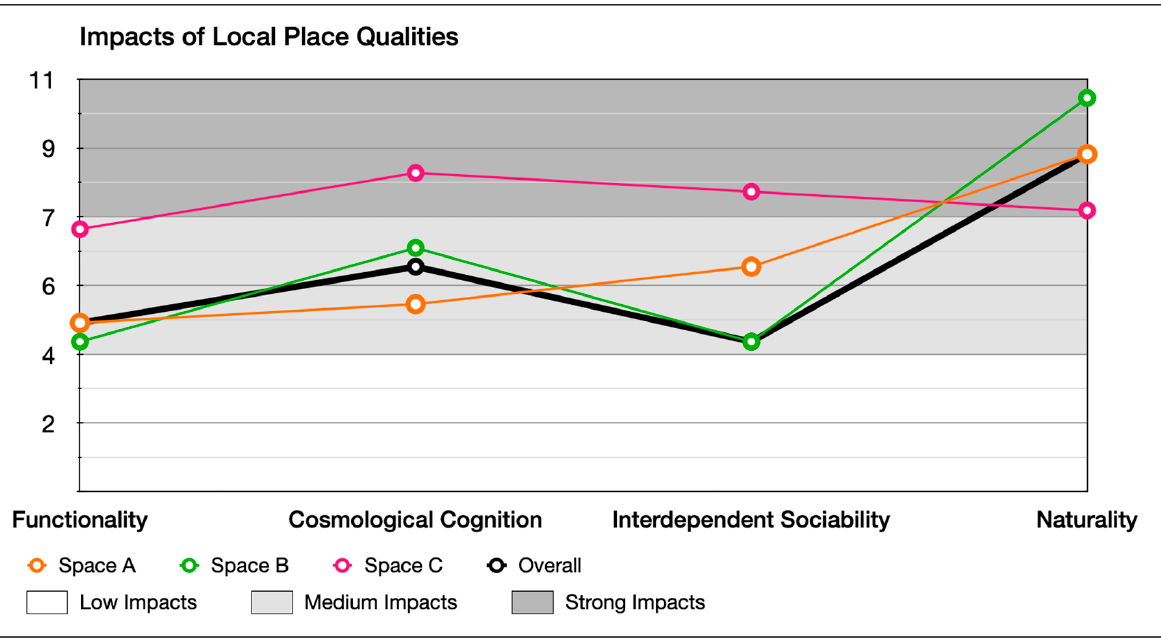
Figure 14. Comparison of impact score of local place qualities in different types of space.